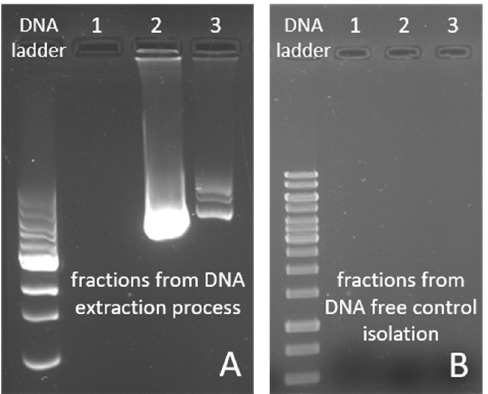
Figure 6. Agarose gel electrophoresis image of isolated pBAD24 plasmid DNA extracted with MnFe 2 O 4 MNPs ( A ) and DNA-free control isolation fractions ( B ). In both pictures, the DNA ladder notation refers to a 1 kb DNA marker. (1) is the supernatant fraction, (2) marks the first elution fractions using 80 µ L of elution buffer, and (3) indicates the second elution fractions (also eluting with 80 µ L of Table 4. DNA concentration of the MnFe 2 O 4 -purified pDNA samples.